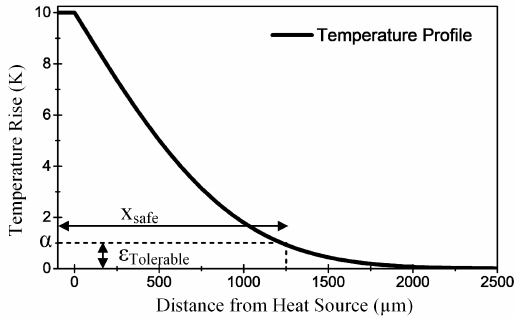
Figure 2. Schematic representation of the temperature profile on top of a silicon photonic IC and definition of the safe distances x safe according to the maximum tolerable temperature rise ε tolerable